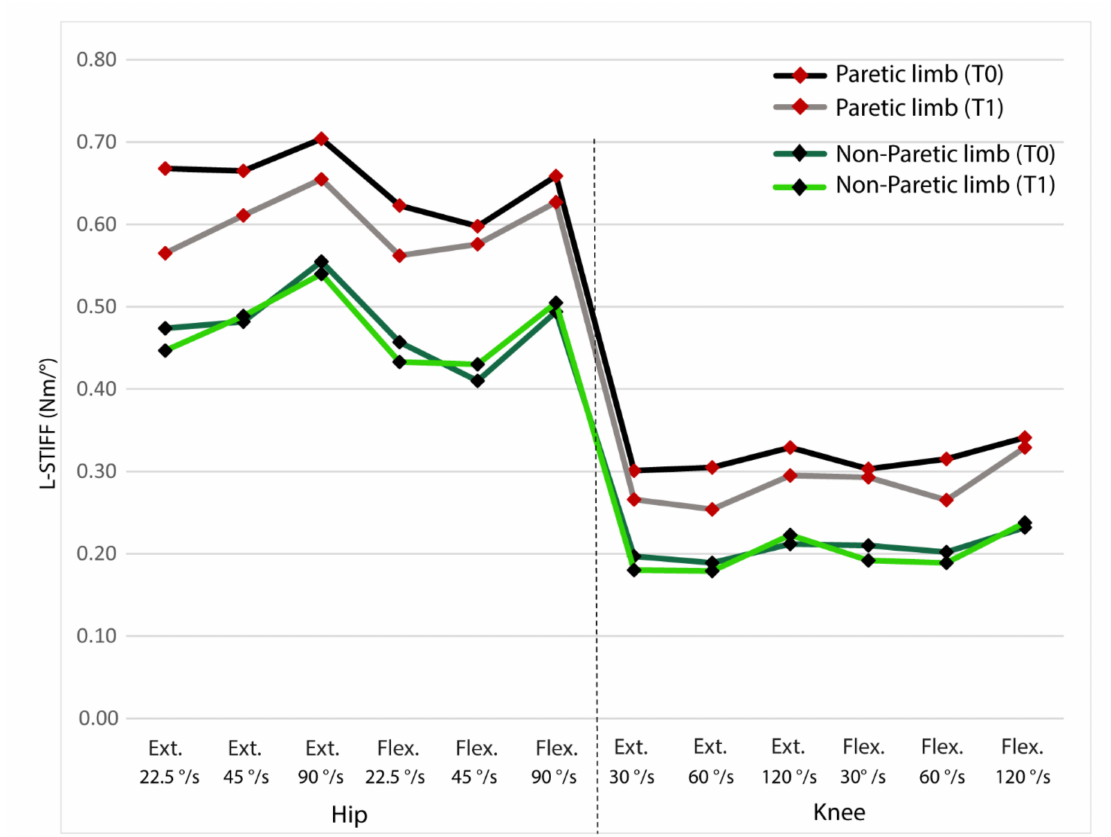
Figure 1. L-STIFF (lower limb-sti ff ) measures (mean) of paretic and non-paretic limb at basal assessments (T0) and one-month follow-up